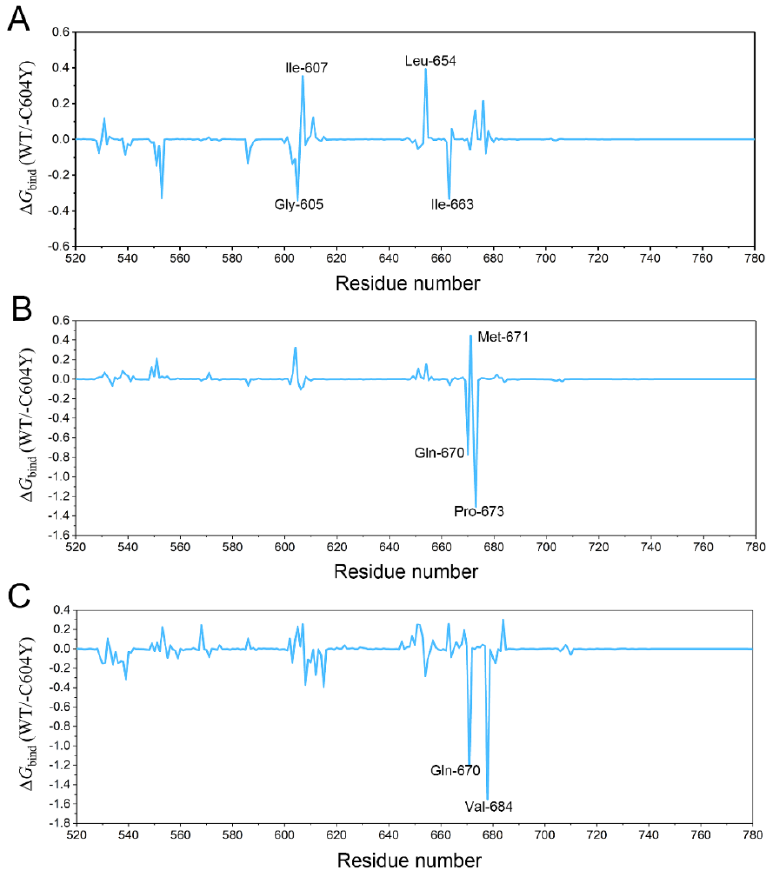
Figure 5. The energetic differences of the residue contributions to the binding free energies between the WT system and C604Y system ( ∆∆ G = ∆ G WT − ∆ G C604Y ). ( A ) Mps1 WT /reversine and Mps1 C604Y /reversine; ( B ) Mps1 WT /Cpd-5 and Mps1 C604Y /Cpd-5; ( C ) Mps1 WT /NMS-P715 and Mps1 C604Y /NMS-P715.